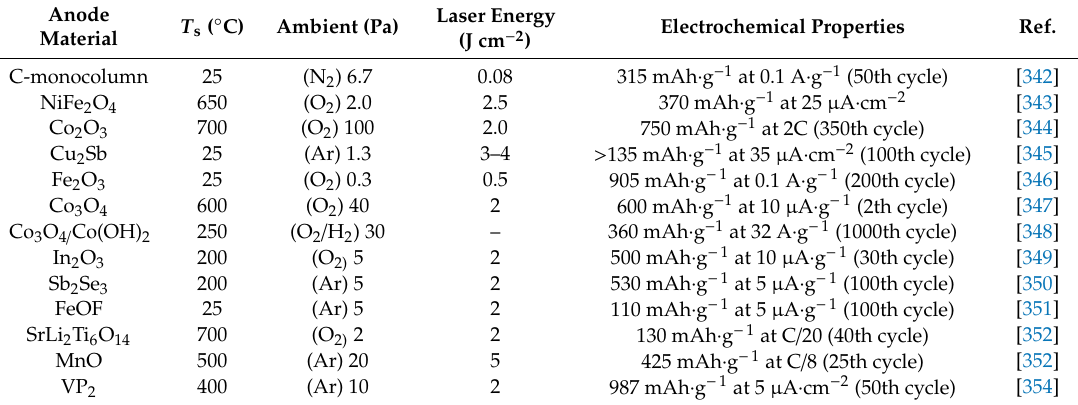
Table 10. Growth conditions and electrochemical properties of new anode